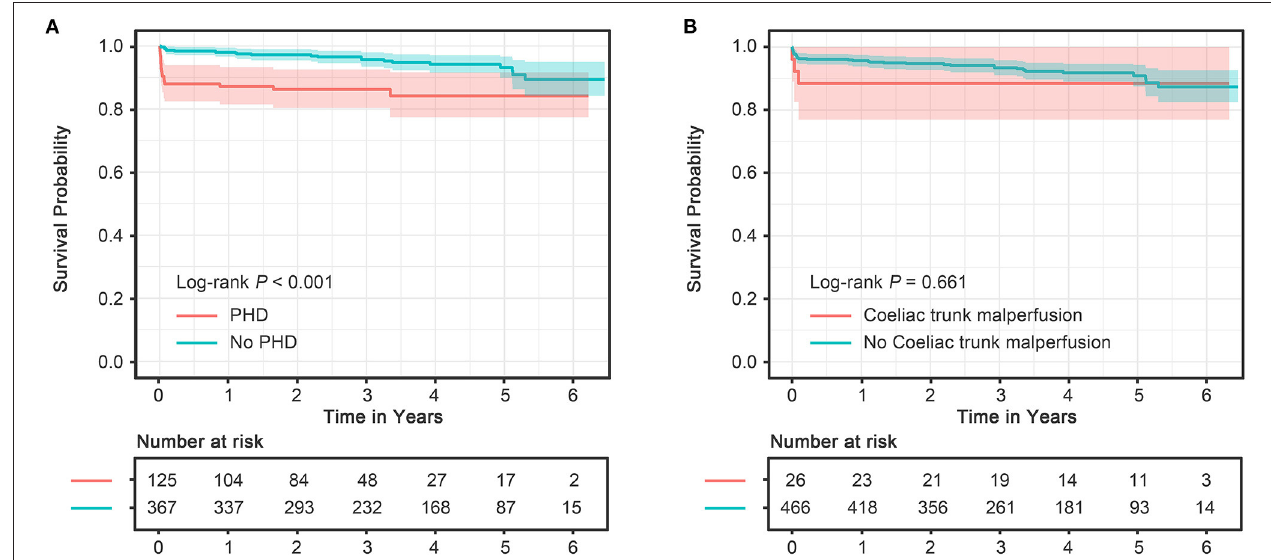
FIGURE 2 | (A) Kaplan–Meier method estimating midterm survival of patients with and without PHD. (B) Kaplan–Meier method estimating midterm survival of patients with and without celiac trunk malperfusion. CI, confidence interval; HR, hazard ratio; PHD, postoperative hepatic dysfunction.